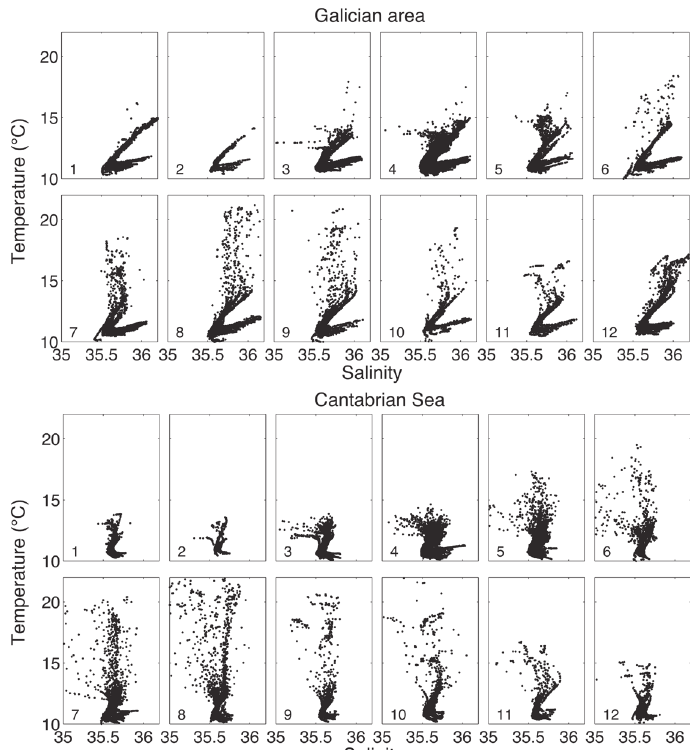
Fig . 5. – Monthly TS diagrams for the interior ocean corresponding to the Galician Area (upper) and Cantabrian Sea (lower).